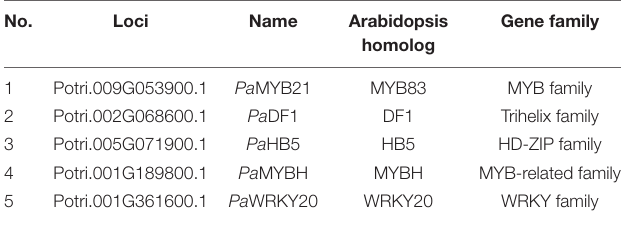
TABLE 1 | Transcription factors that bind to the PaPAL2 promoter identified in the Populus wood-associated library using